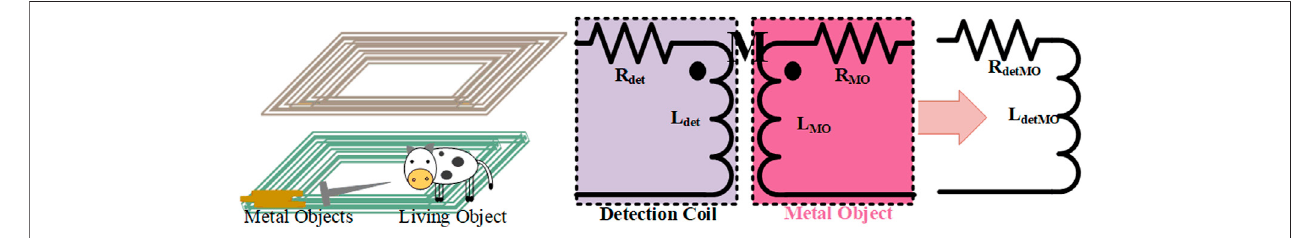
FIGURE 5 | Representation and equivalent circuit of